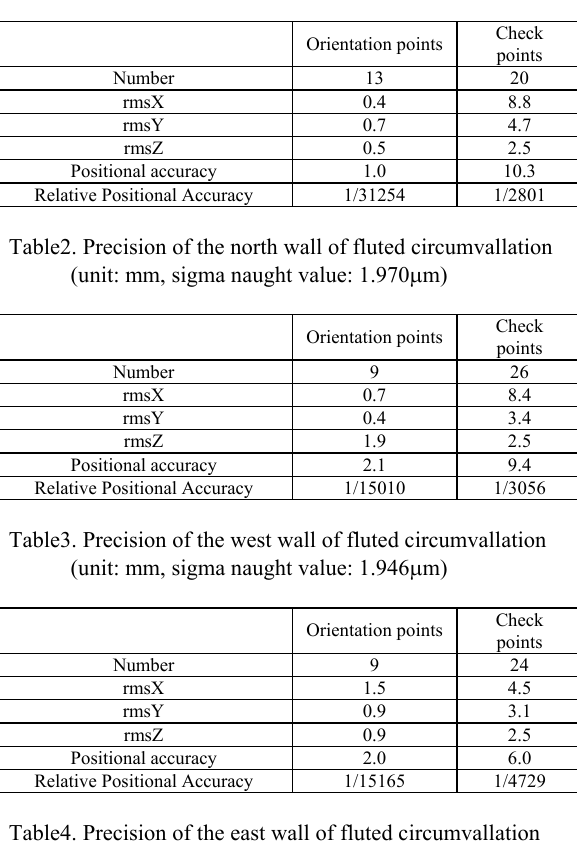
Table4. Precision of the east wall of fluted circumvallation (unit: mm, sigma naught value: 1.810 μ